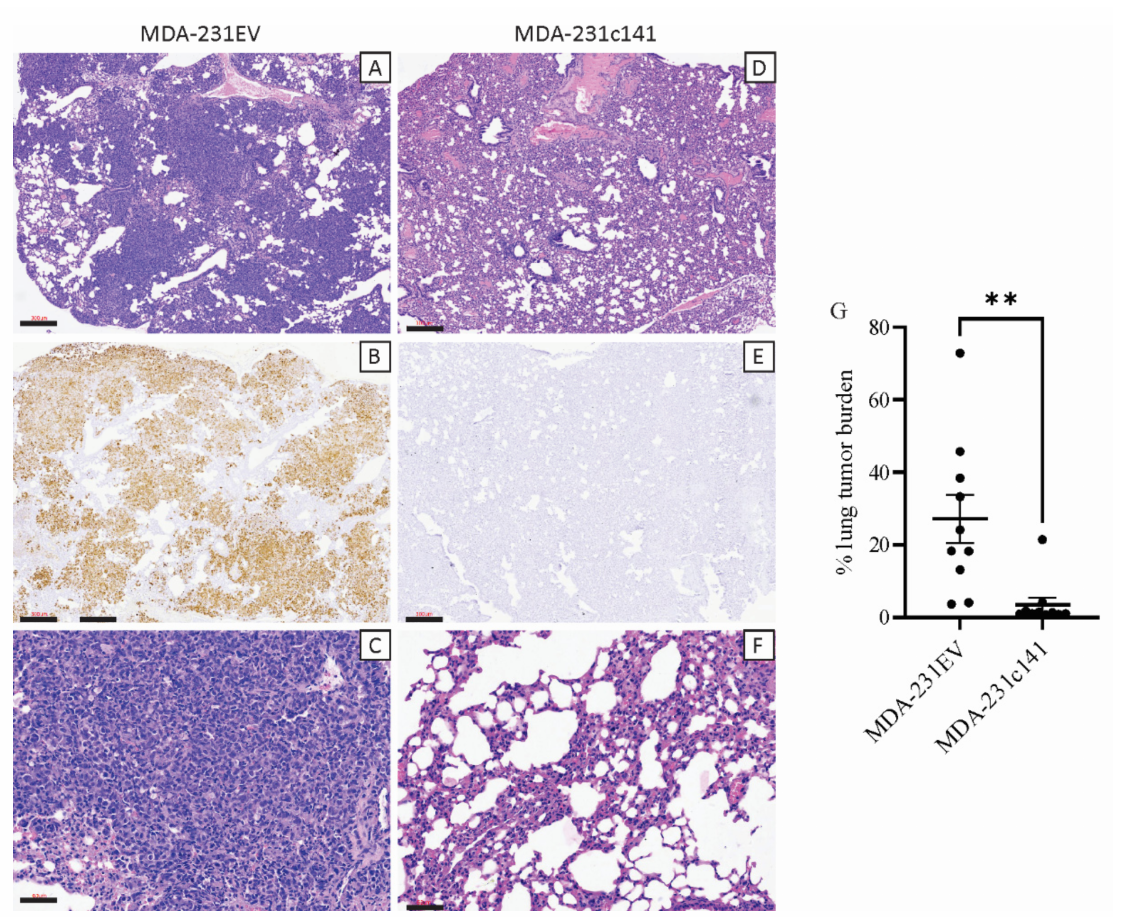
Figure 2. Lung sections from mice harbouring ( A – C ) MDA-231EV or ( D – F ) MDA-231c141 primary mammary tumors. Panels ( A , D ) show hematoxylin and eosin stained lung metastases at lower magnification while, panels ( C , F ) show representative lung sections at higher magnification. Panels ( B , E ) show staining of the lung metastases with a human, anti-vimentin antibody and the percentage of the lungs containing cells staining positive for human vimentin are quantified in ( G ). Scale bars of ( A , B , D , E ) are 300 µ m while scale bars for ( C , F ) are 60 µ m. ( G ) Quantification of lung tumor burden. To calculate lung tumor burden, the area of the lung with positive vimentin staining was expressed relative to the total lung area. The individual values have been indicated along with the mean ± SEM. A Student’s t -test was performed and significance is indicated as ** p <